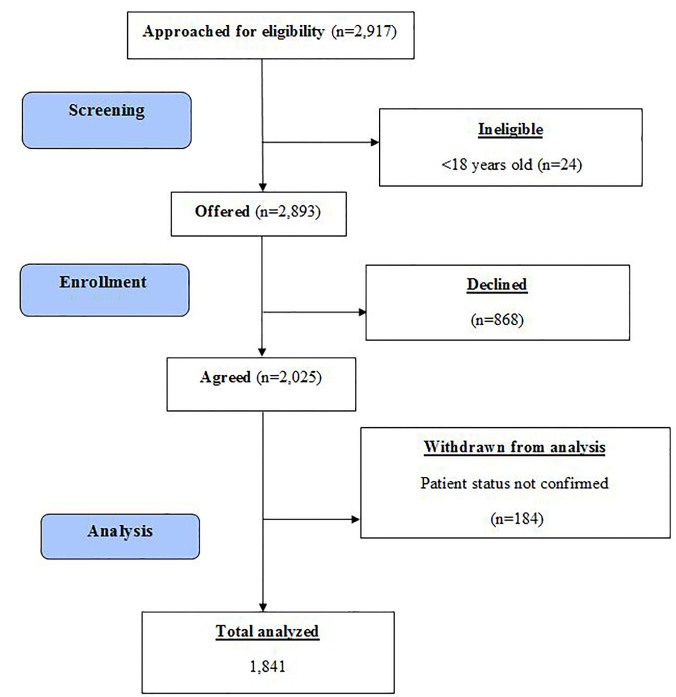
CONSORT flow diagram.